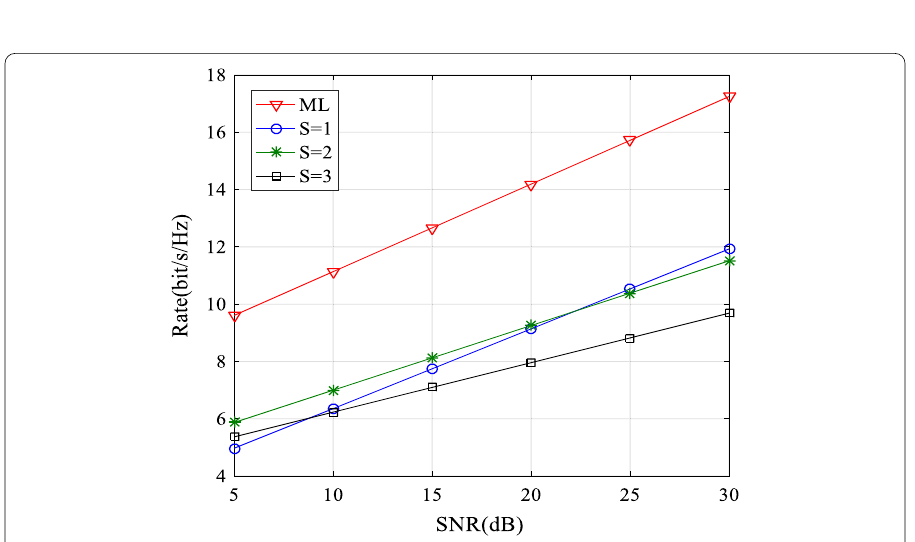
Fig. 11 Data rate of the different search